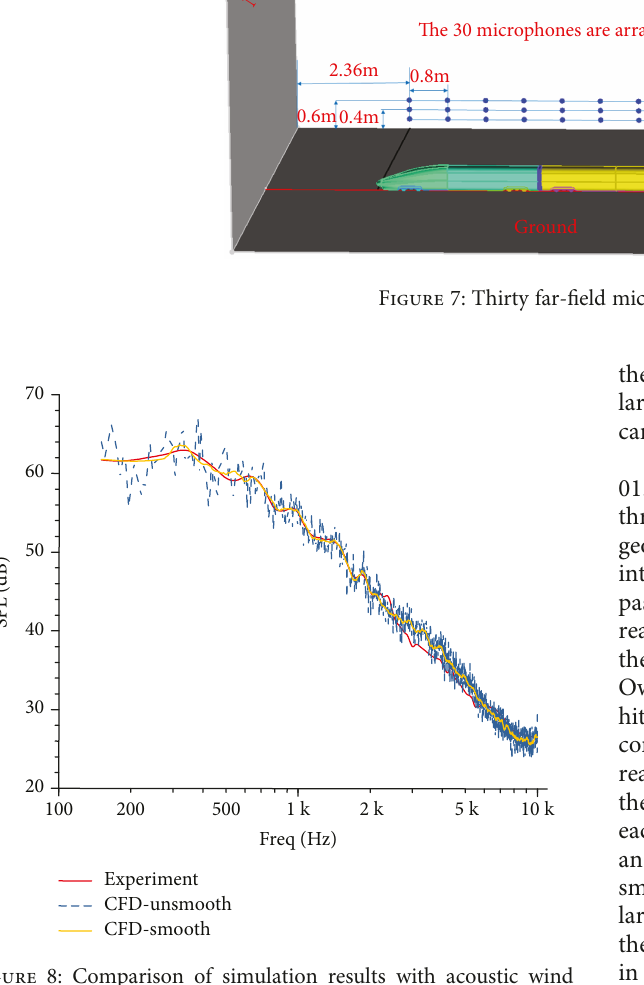
Figure 8: Comparison of simulation results with acoustic wind tunnel test results 0 (55.56